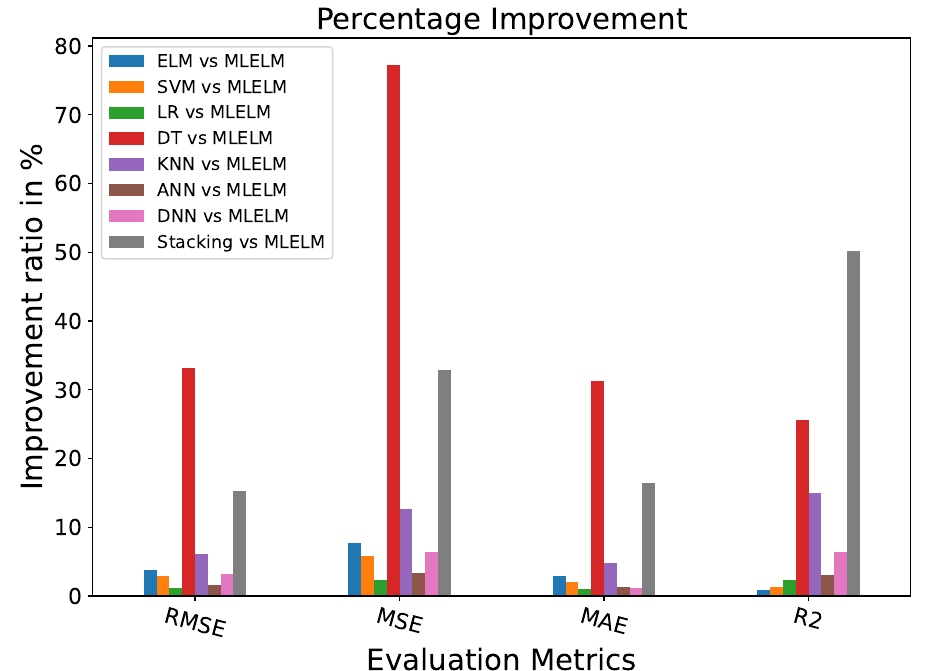
Figure 11. The Percentage Improvement Ratio (PIR) between the proposed MLELM and the com- pared